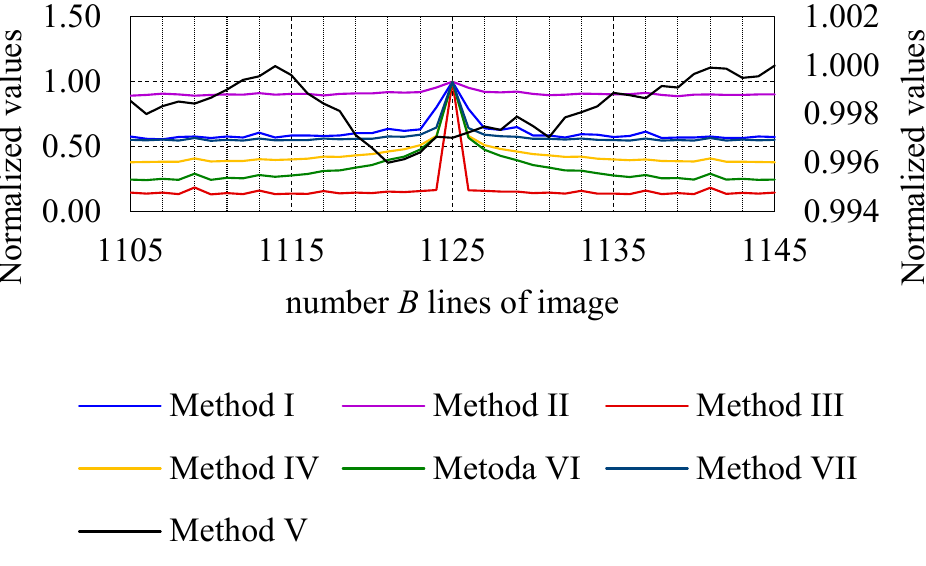
Figure 13. Normalized values (in relation to the maximum value) of the variability of measures as a function of the number of image lines, supporting the determination of the correct number of lines of the image reproduced for the source image in the form of a picture from Figure 7b—HDMI graphic standard, computer monitor operating mode 1280 × 1024/60 Hz, frequency of the reveal emission signal 𝑓 (cid:3042) = 200 MHz , reception bandwidth 𝐵𝑊 = 100 MHz , correct number of lines 𝐵 (cid:3004)(cid:3042)(cid:3045)(cid:3045) = 1125 .